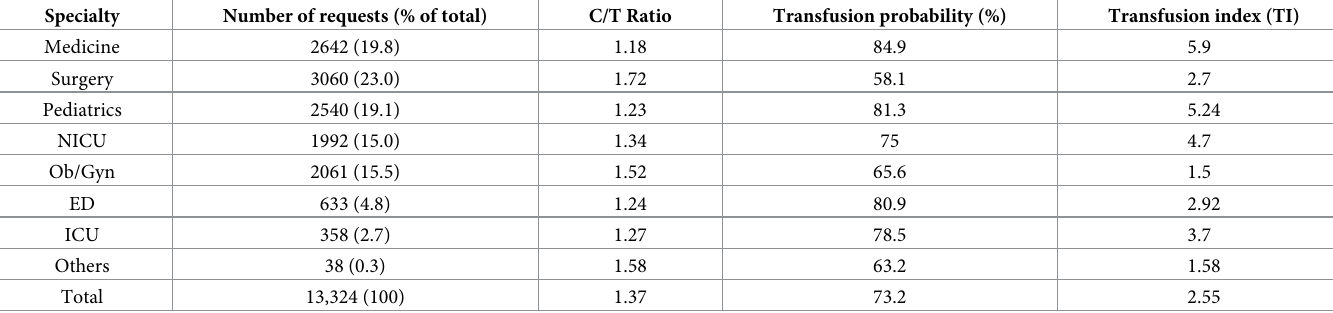
Table 4. Quality indicators for blood bank utilization by